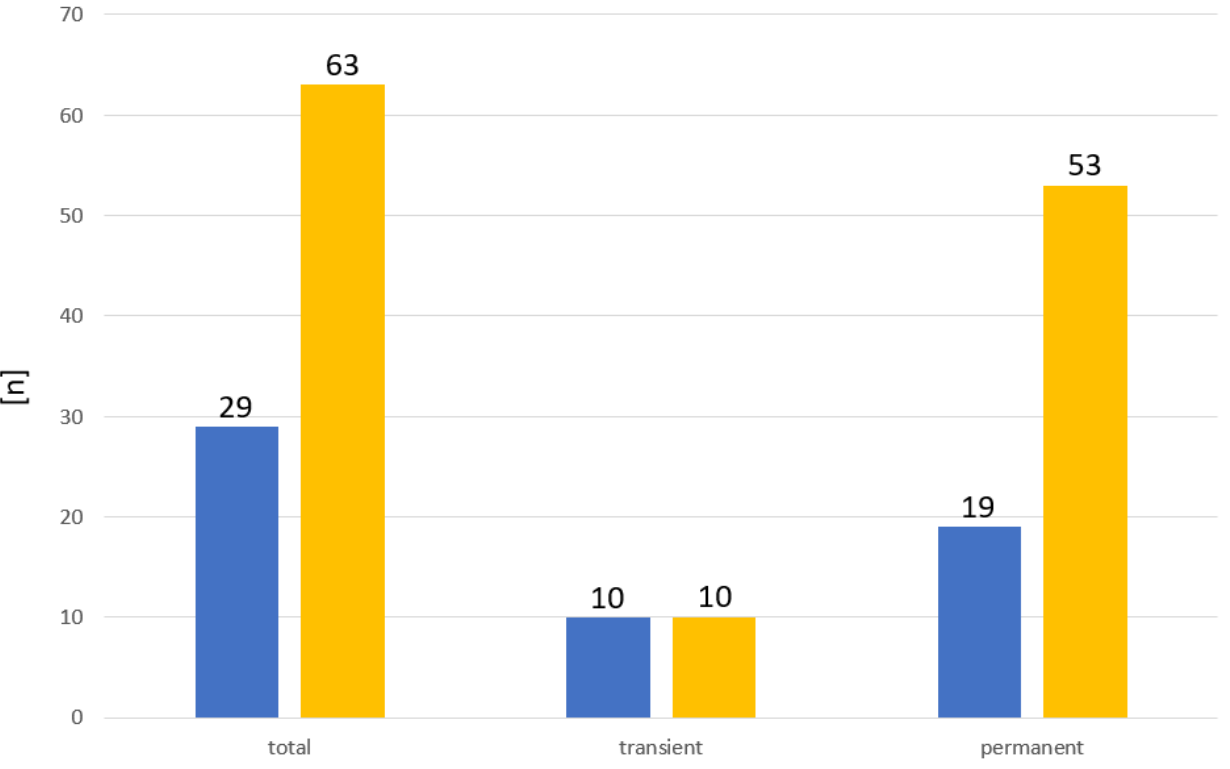
Figure 2. Sex distribution in patients with CH. ■ Male. ■ Female.